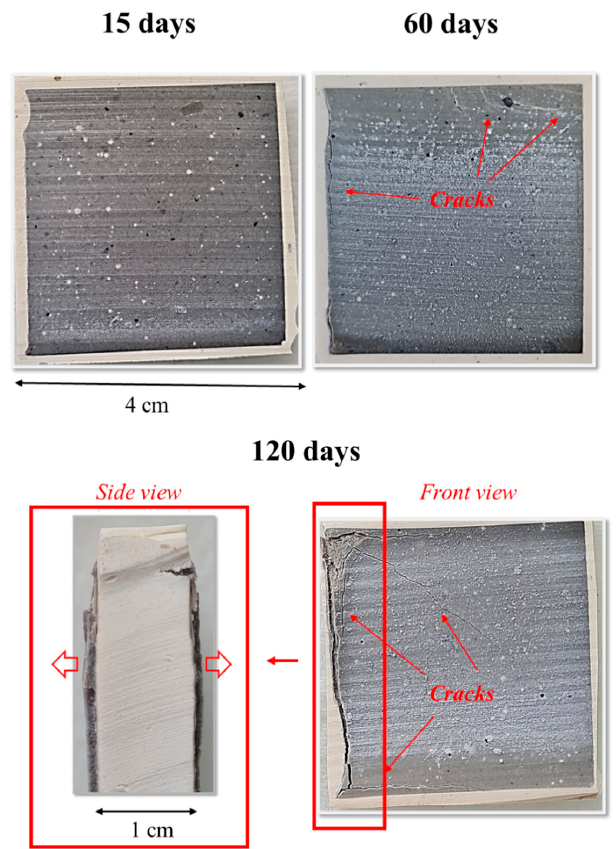
Figure 8. Pictures of cement-paste degradation after 15, 60, and 120 days. Macroscopic cracking was observable on the samples at 60 days and the expansion at 120 days occurred in the opposite direction of diffusion (side view).